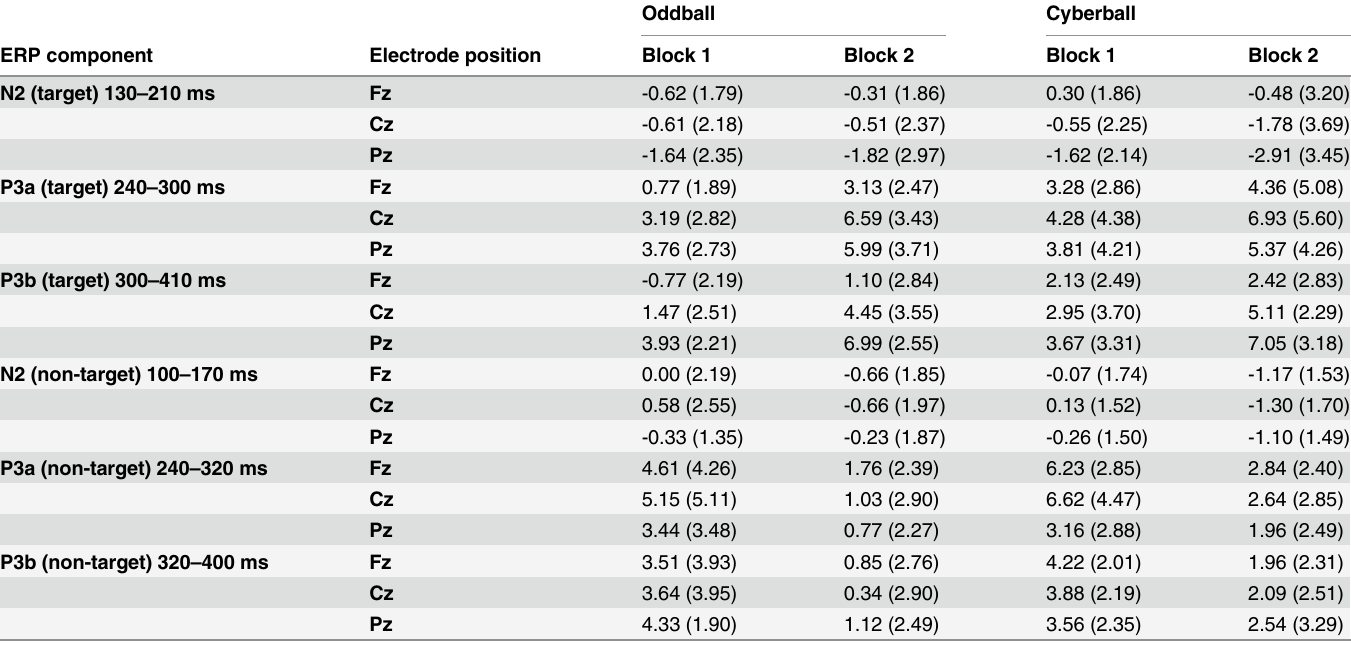
Table 2. Electrophysiological data of the Oddball and Cyberball group for the two experimental blocks.